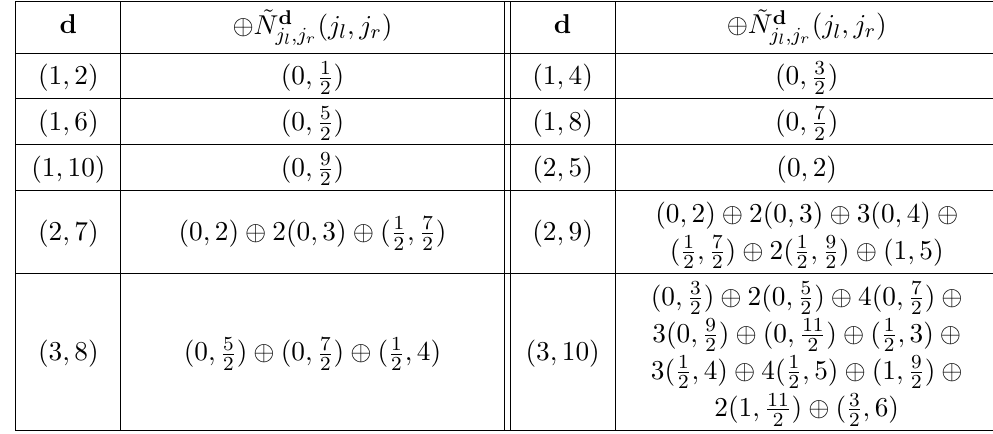
Table 2 . Spectrum of BPS bound states to a fundamental Wilson loop in the SU(2) π theory for d 1 ≤ 3 and d 2 ≤ 10 . Here, d = ( d 1 , d 2 ) labels the BPS states with charge d 1 m + d 2 φ .